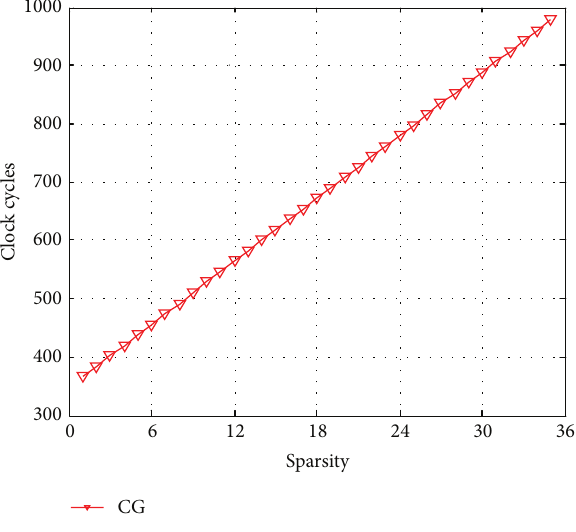
Figure 7: Clock cycles of CG iteration